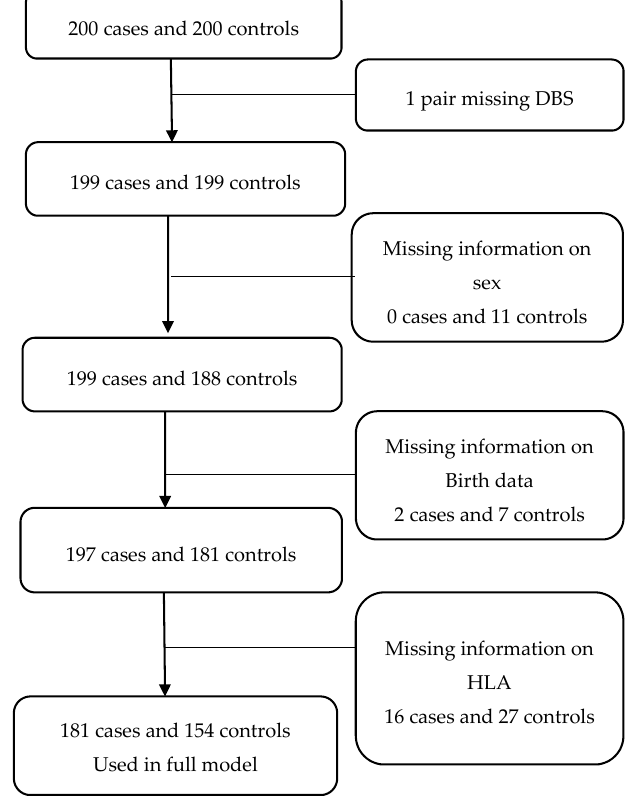
Figure 1. Flowchart illustrating patients participating in the study cohort.